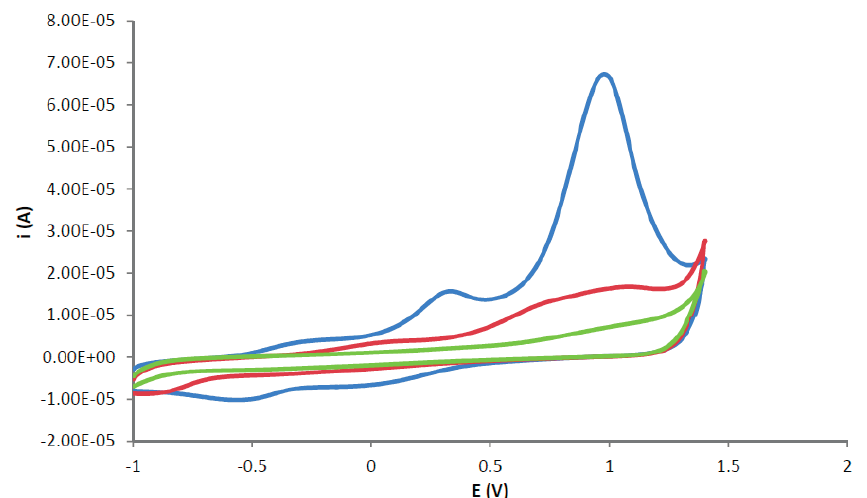
Figure 1. Cyclic voltammograms of the template removal using an aqueous solution of 0.05 mol·L − 1 KCl and phosphate buffer (pH = 7.0) at a scan rate of 0.05 V·s − 1 and 3 scan cycles (blue-3 scans; red-2 scans; green 3